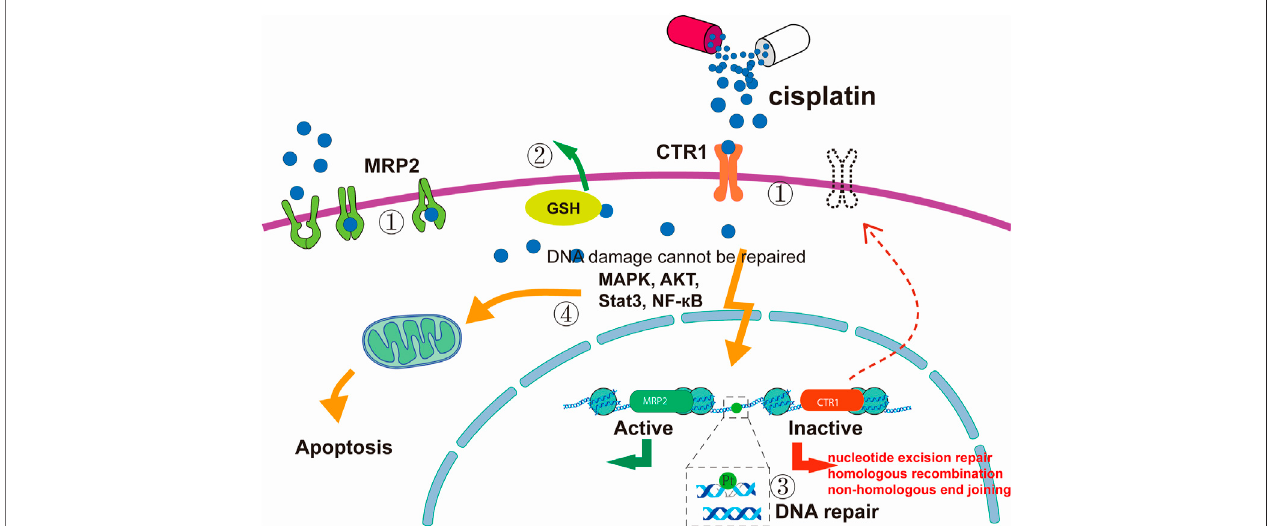
FIGURE 2 | Cisplatin resistance mechanism. (1) Reduced intracellular accumulation of cisplatin. (2) Increased sequestration of cisplatin by GSH and other cytoplasmic scavengers with nucleophilic properties. (3) Enhanced DNA damage repair ability. (4) Defects in apoptotic signal transduction pathways. The fi gure was drawn in Adobe